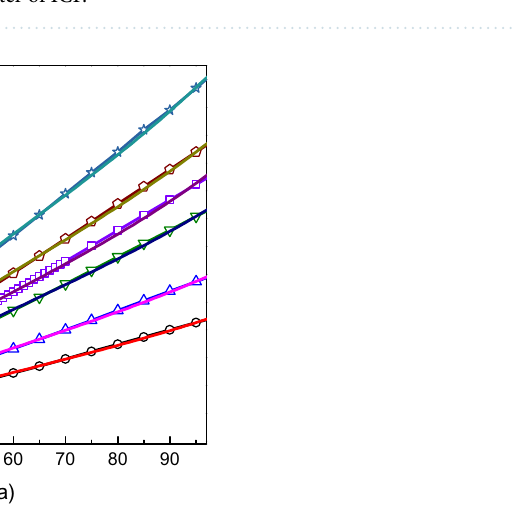
Figure 4. Comparison of experimental and simulated data of the axial electron density distribution ( a ) and the radial electron density distribution ( b ) at the center of ICP.